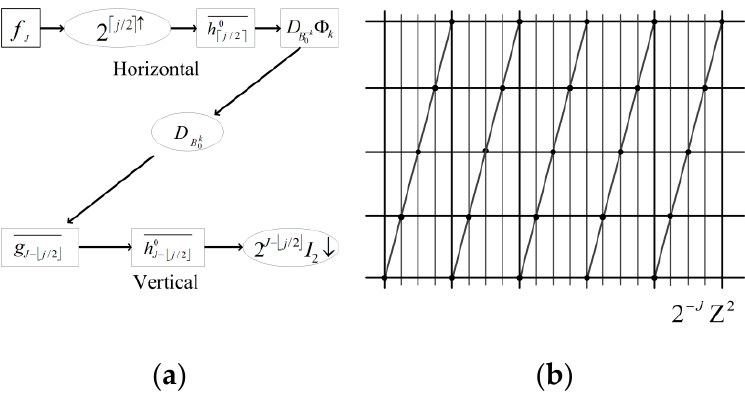
Figure 2. ( a ) Two computation steps for discrete separable shearlet transform (DSST) coefficients: refinement along the horizontal axis (top) and resampling associated with shear matrix (middle), followed by the separable wavelet transform along the vertical axis (bottom); ( b ) refinement along the horizontal axis to obtain the coefficients when j = 4 and k = 1 .